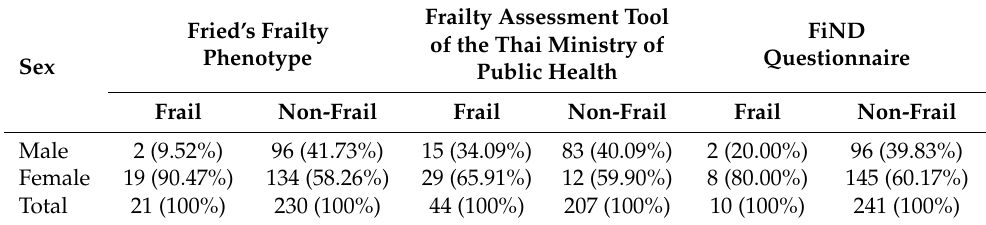
Table 3. Comparison of number and percent of frail and non-frail participants using Fried’s Frailty Phenotype, the Frailty Assessment Tool of the Thai Ministry of Public Health, and FiND questionnaire by